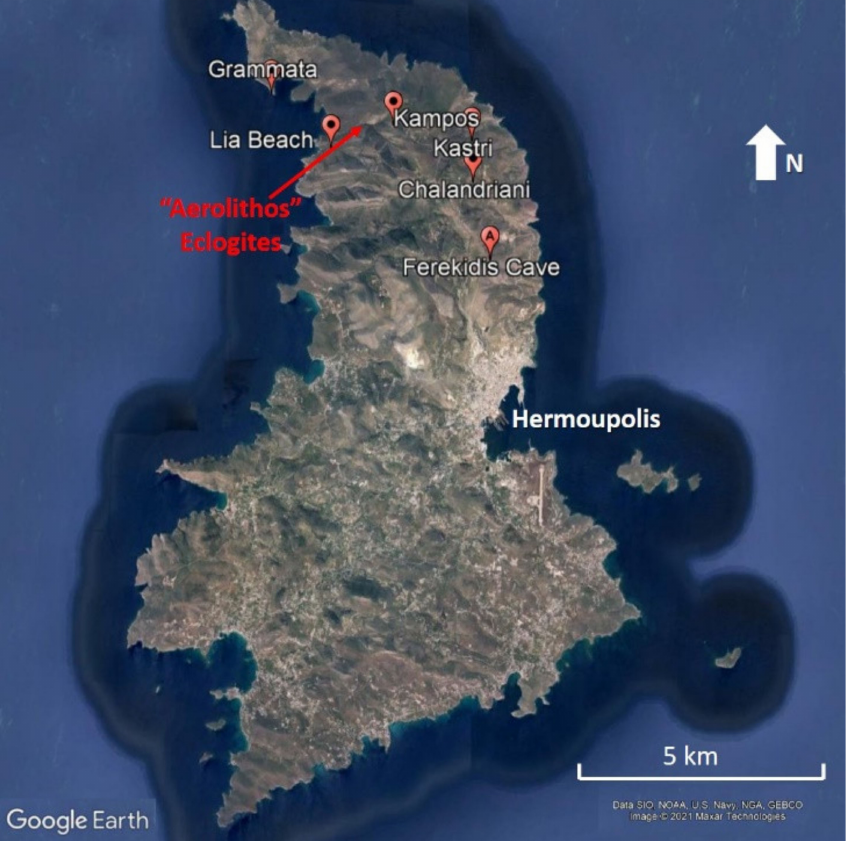
Figure 8. Satellite photo of Syros island, indicating the sites of archaeological interest surrounding the “Aerolithos” Eclogite